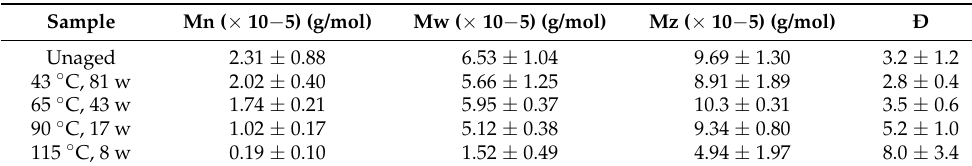
Table 1. Molar mass averages representing the number, mass, and z-average molar masses (M n , M w , and M z , respectively) and dispersity (Ð = M w /M n ). Data presented are mean ± standard error of the mean (S.E.M.), where n ≥ 3.